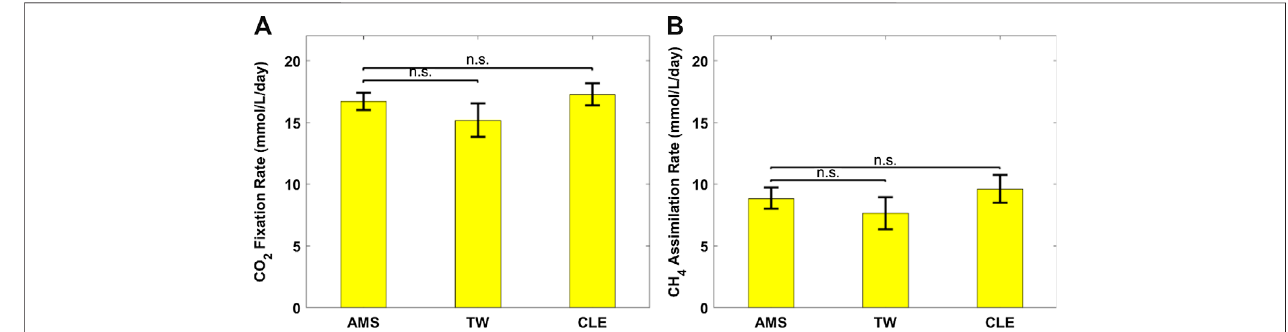
FIGURE 5 | (A) CO 2 fi xation rate of Chlorella sorokiniana and (B) CH 4 assimilation rate of Methylococcus capsulatus . The Dunnett ’ s test, with ammonium mineral salts (AMS) as the control, indicates that these differences are not signi fi cant (n.s.) statistically at signi fi cance level α (cid:2) 0.05.